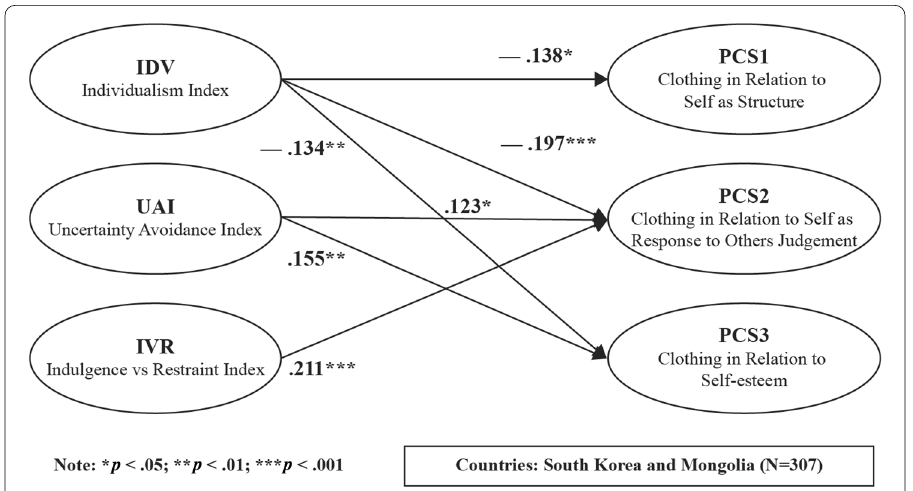
Fig. 2 Results of multiple regression